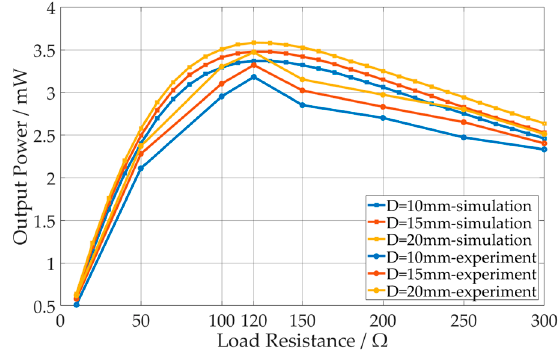
Figure 7. Determination of the optimal load resistance.